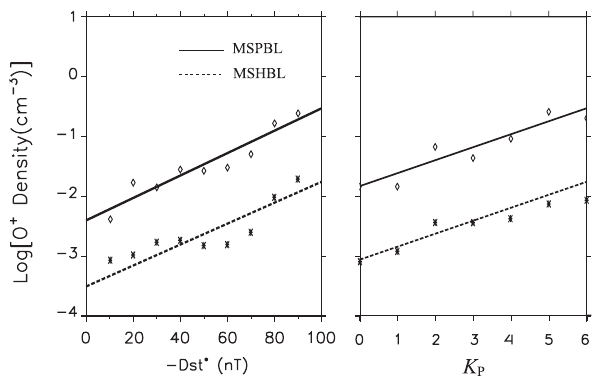
Fig. 11. Plot of the log of the average O + number density as a function of − D st ∗ (left) and K p (right) in the MSPBL (solid line with diamonds) and MSHBL (dotted line with